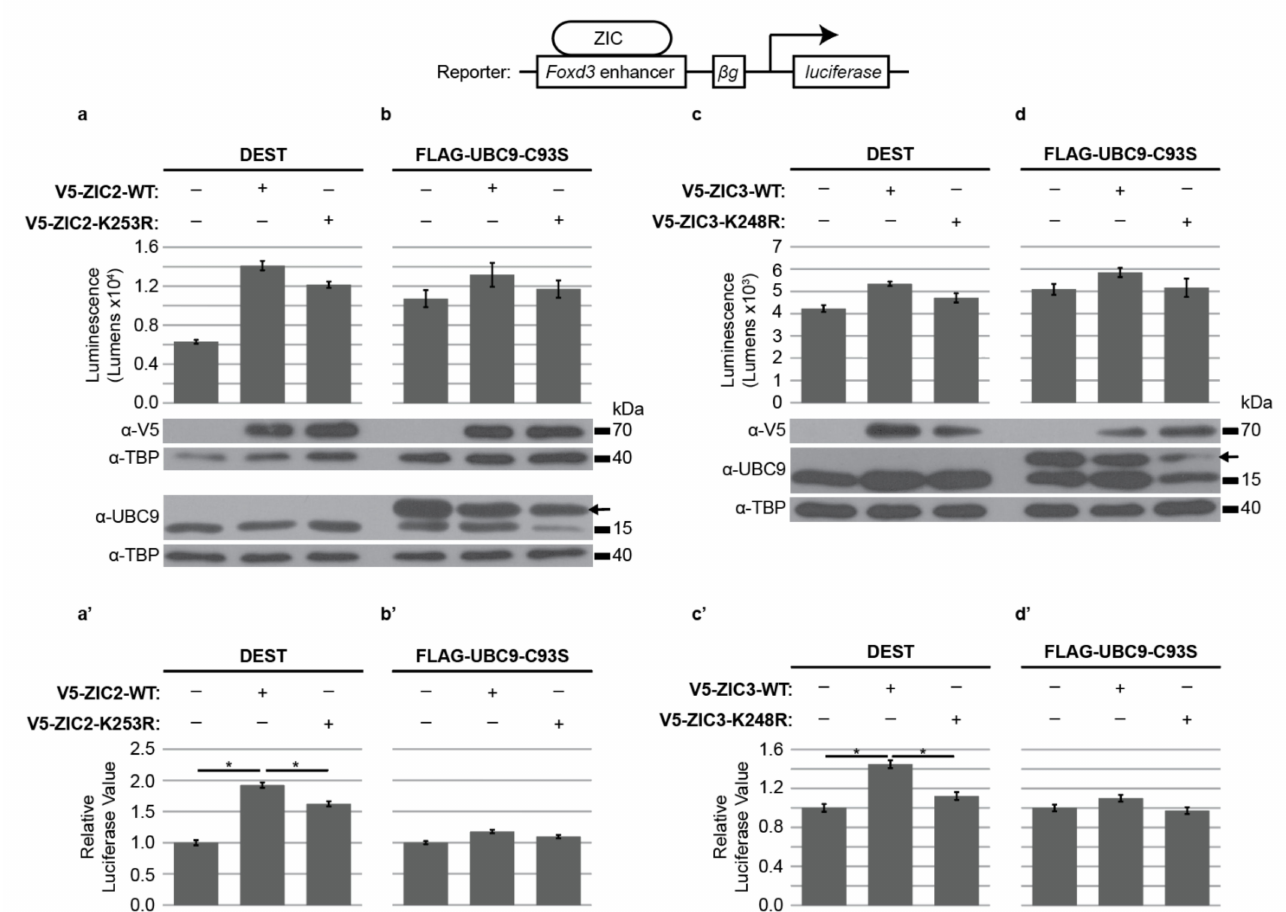
Figure 3. SUMOylation increases ZIC2 and ZIC3 transactivation of the Foxd3 enhancer. Luciferase activity at the Foxd3 reporter in HEK293T cells. ( a , a ’) The K253R SUMO-incompetent form of ZIC2 shows a significant decrease in transactivation ability compared to wild-type ZIC2. ( b , b ’) The transactivation ability of wild-type ZIC2 is impeded when SUMOylation is universally inhibited via UBC9-C39S and is equivalent to the SUMO-incompetent form of ZIC2. ( c , c ’) The K248R SUMO- incompetent form of ZIC3 shows a significant decrease in transactivation ability compared to wild-type ZIC3. ( d , d ’) The transactivation ability of wild-type ZIC3 is impeded when SUMOylation is universally inhibited via UBC9-C39S and is equivalent to the SUMO-incompetent form of ZIC3. ( a – d ) Raw data and WB showing overexpressed proteins from one representative experiment. For WB of nuclear fractions (using antibodies against V5 or UBC9) antibody against TBP was used as a loading control. The arrow in the UBC9 WB denotes the larger, tagged exogenous protein. In ( a , b ), the ZIC and UBC9 proteins were detected on separate blots, whereas in c and d all proteins were detected on one blot. Error bars denote ± s.d. from three internal repeats. ( a ’– d ’) Pooled data from three external repeats (normalized to background). Error bars denote ± s.e.m. *: p < 0.05, two way ANOVA with Bonferroni multiple comparison